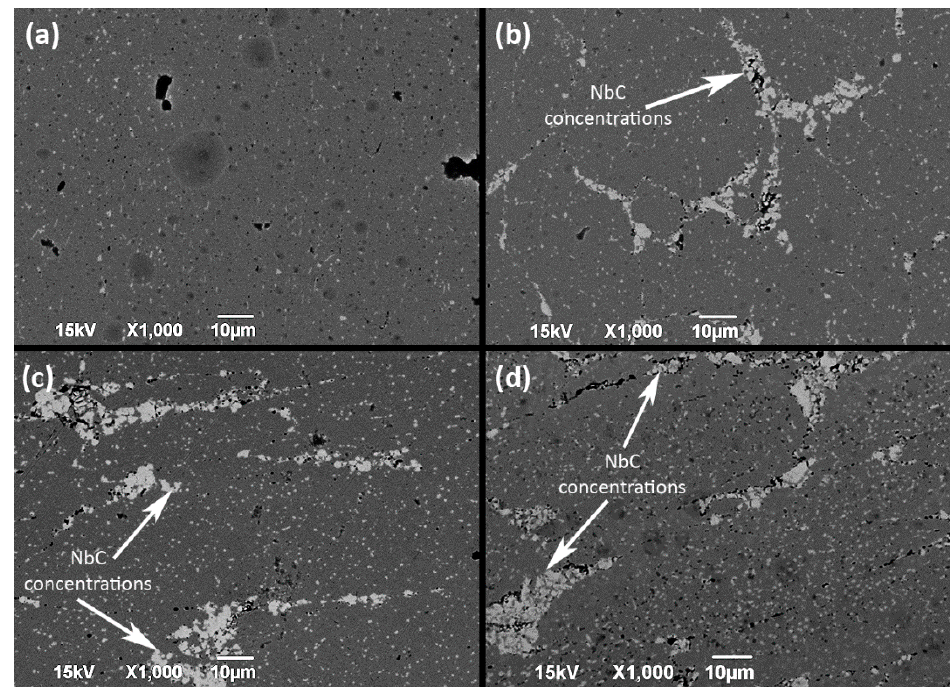
Figure 5. Enlarged microstructures of ( a )—Pure Inconel 625 (reference sample), ( b )—5% NbC, ( c )—10% NbC, ( d )—20% NbC reinforcement and its influence on microstructure of Inconel 625 MMC. Scale applies to each micrograph.